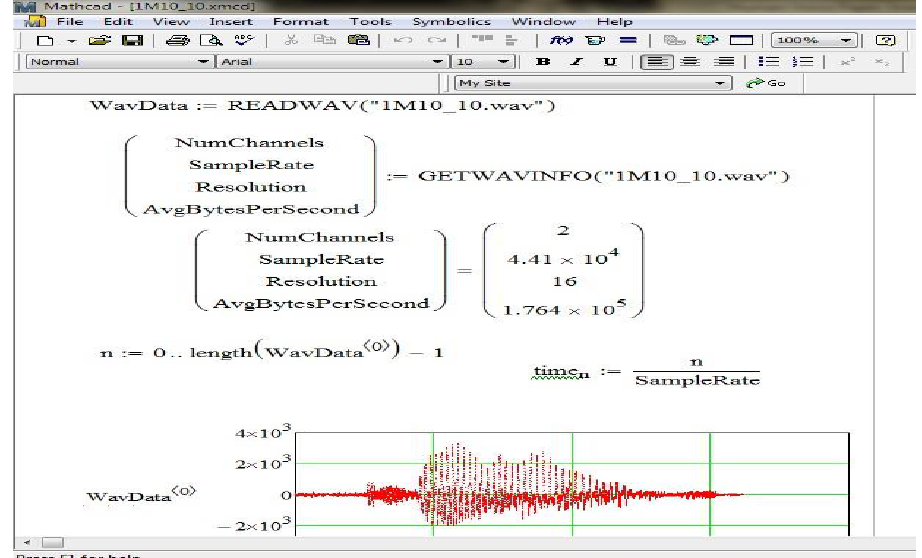
Fig. 2: A typical screenshot of the software Math Cad – 14 while processing a sound segment to find the